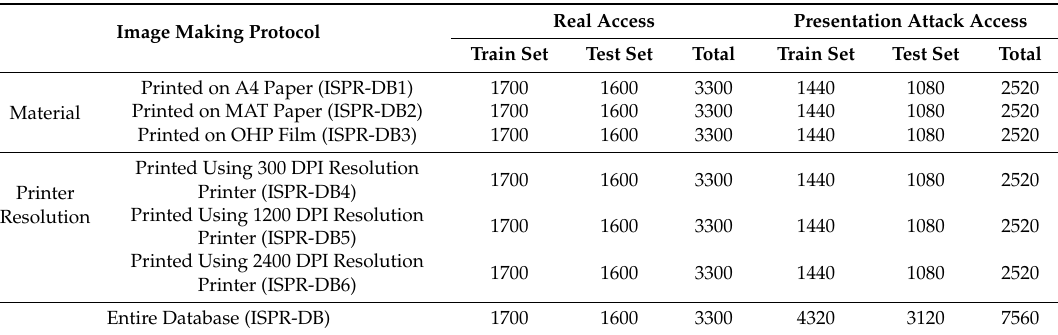
Table 6. Description of ISPR presentation attack finger-vein image database.